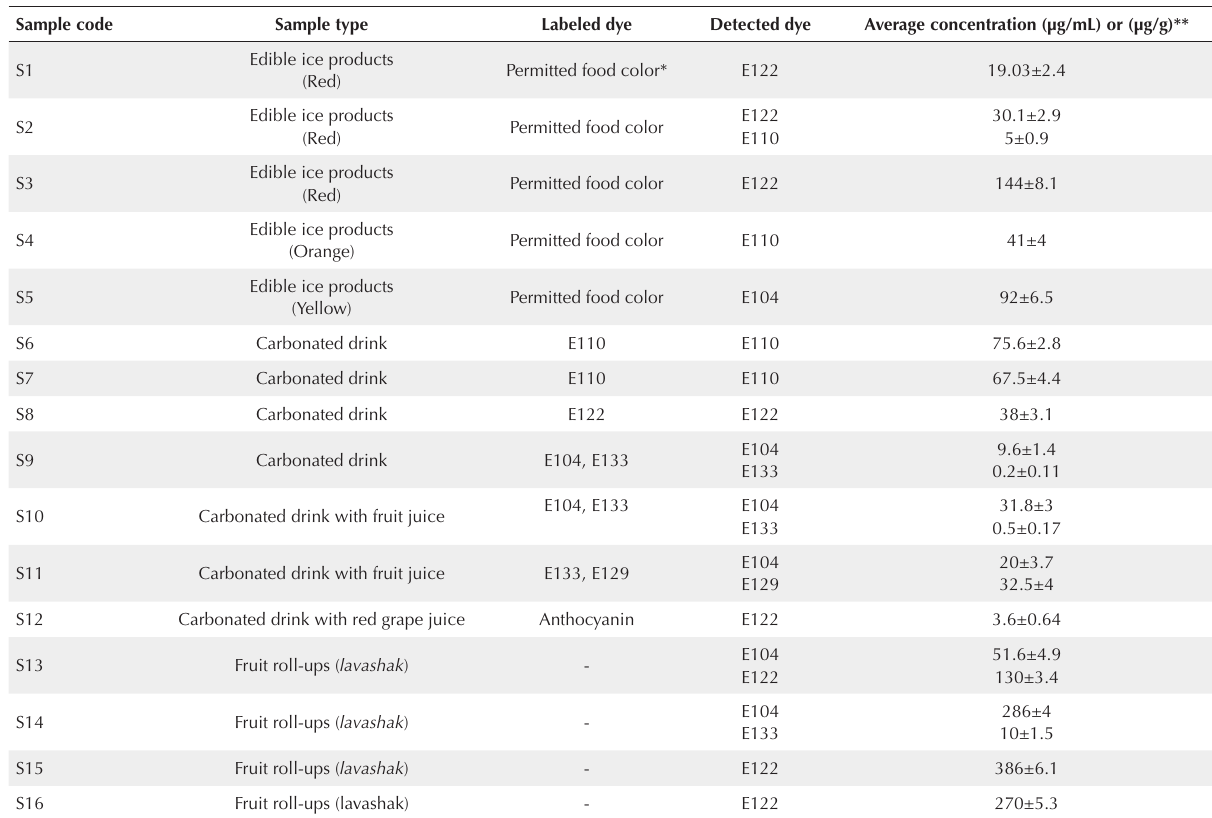
Table 5. The Amount of Synthetic Colors in Real Samples Sample code